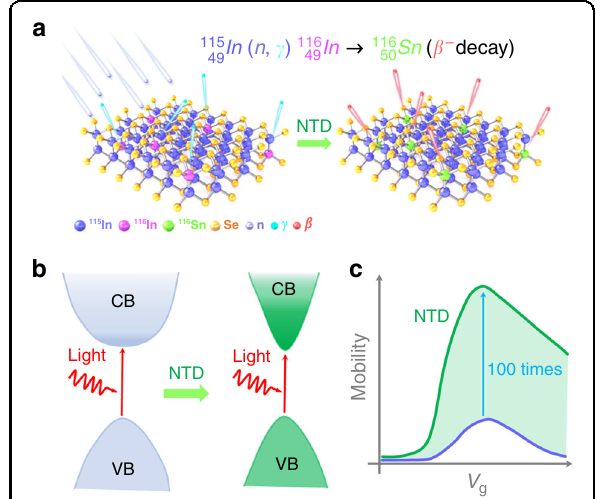
Fig. 1 Electric and photoelectric properties of 2D layered InSe manipulated by a “ clean ” neutron transmutation doping. a Transmutation neutron doping (NTD) scheme for 2D layered InSe, including the capture of thermal neutrons and decay of γ and β - particles. b , c Energy band structures and mobility in 2D layered InSe before and after transmutation neutron doping. CB and VB represent the conduction band and valence band,